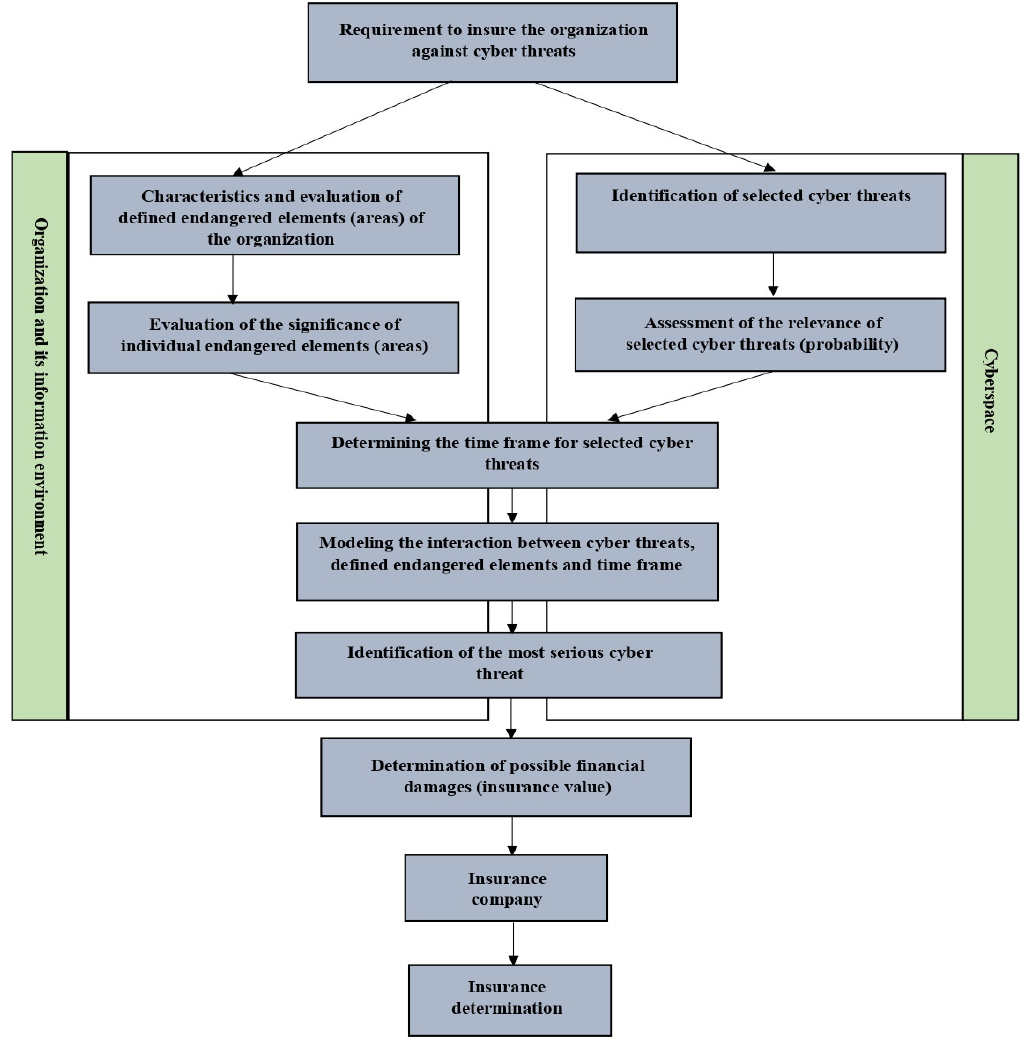
Figure 2. Scheme of algorithm for dynamic risk assessment (own resource).